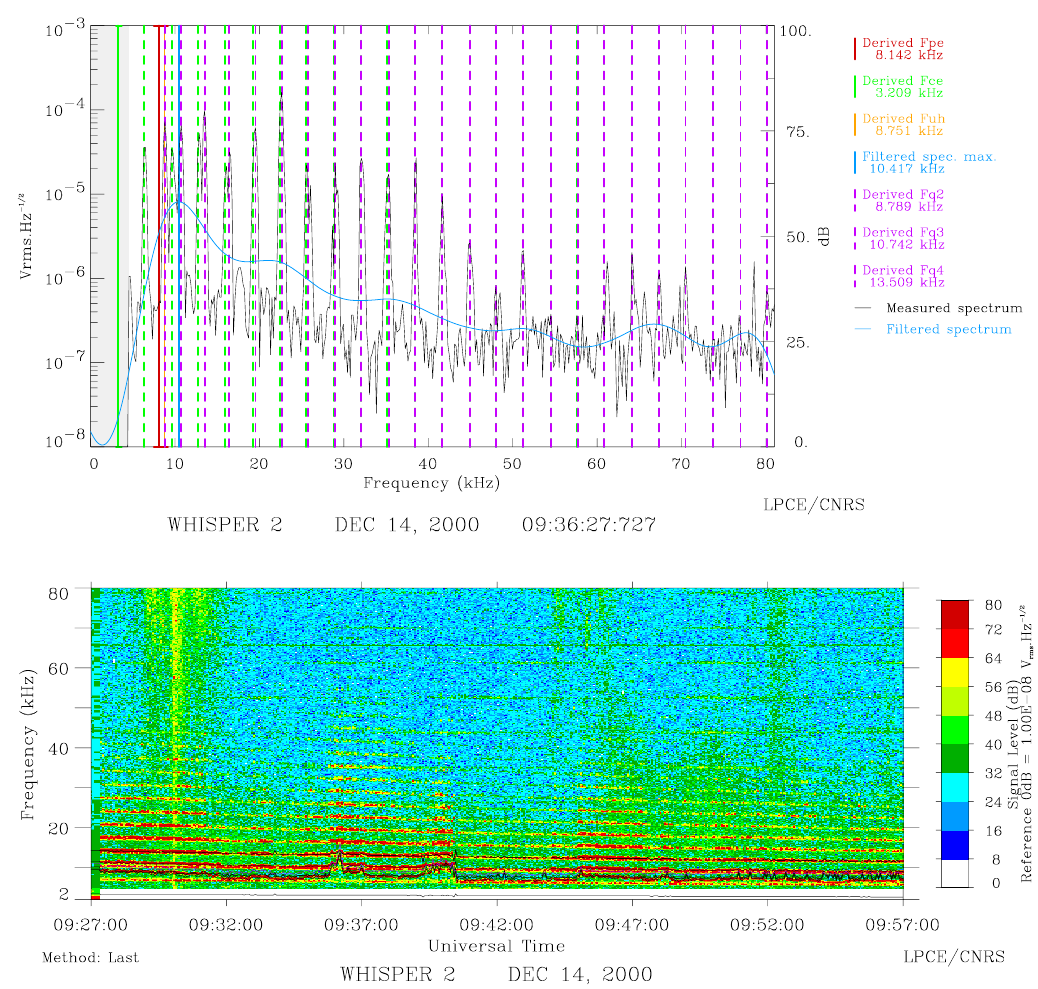
Fig. 6. Results of the resonance recognition process for a magnetospheric pass (bottom) and one of the individual spectra (top). See explanations in the text. Cluster-2 was located at X GSE = − 2 . 7 R E , Y GSE = 2 R E , Z GSE = 7 . 3 R E